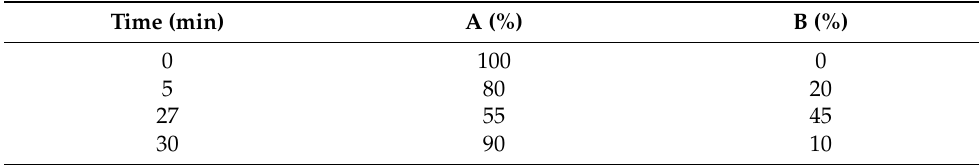
Table 1. Mobile phase gradients for UPLC